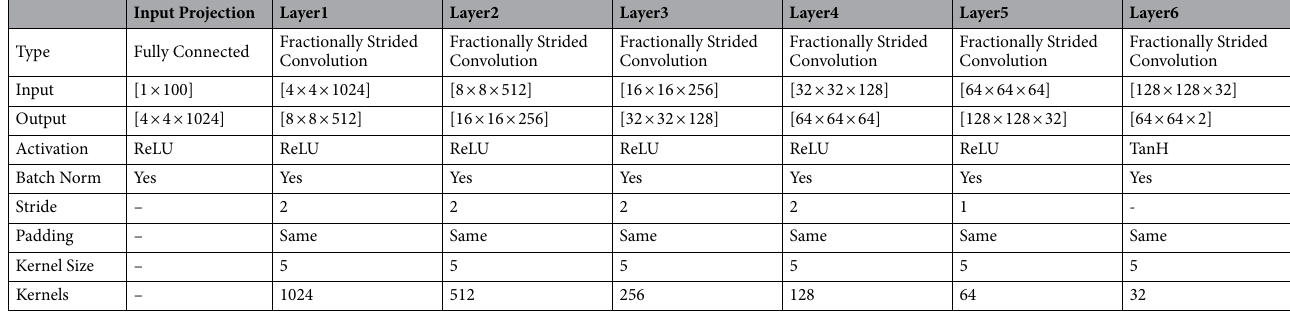
Table 1. Generator architecture: we adopted the input noise vector of dimensionality 100 drawn from a zero- mean Gaussian distribution. Minibatch size: 32, optimizer: adaptive moment estimation (Adam) (η = 0.00001, β1 = 0.5, β2 = 0.999). All weights were initialized using the normal distribution initializer.